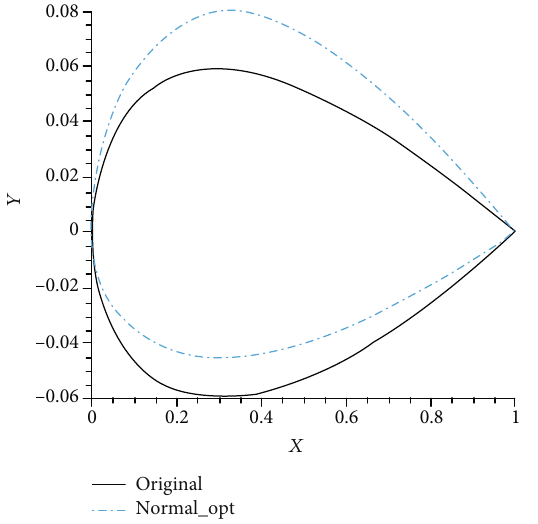
Figure 6: Geometric shape after conventional optimization.